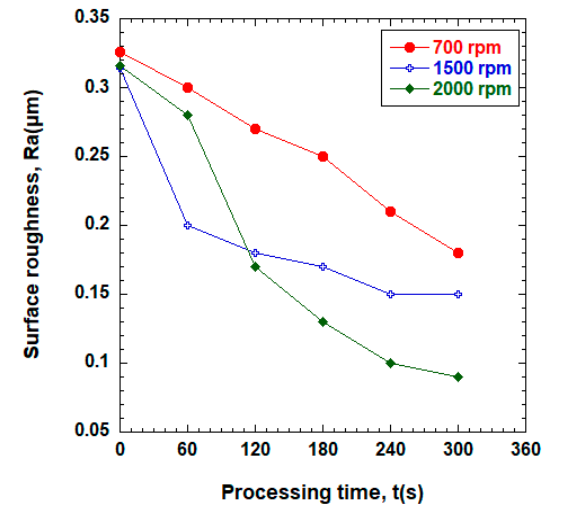
Figure 5. Surface roughness (Ra) vs. processing time as a function of rotational speed (vibration: 8 Hz; abrasive: 1 μ m; sharp edge; gap: 3 mm).